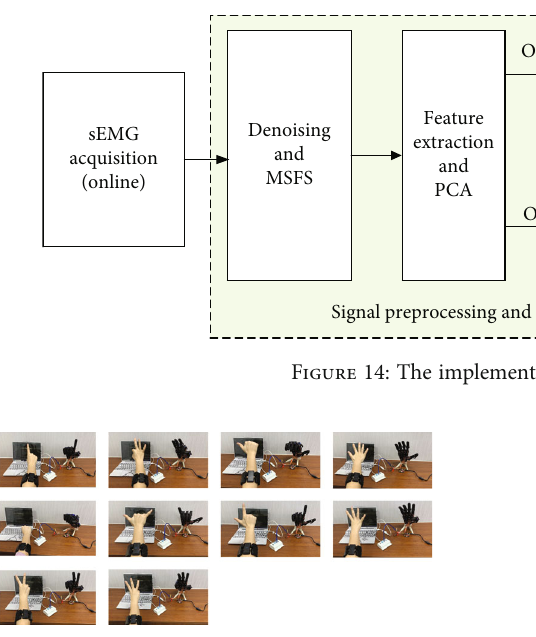
Figure 15: The status of intelligent prosthetic hand control.